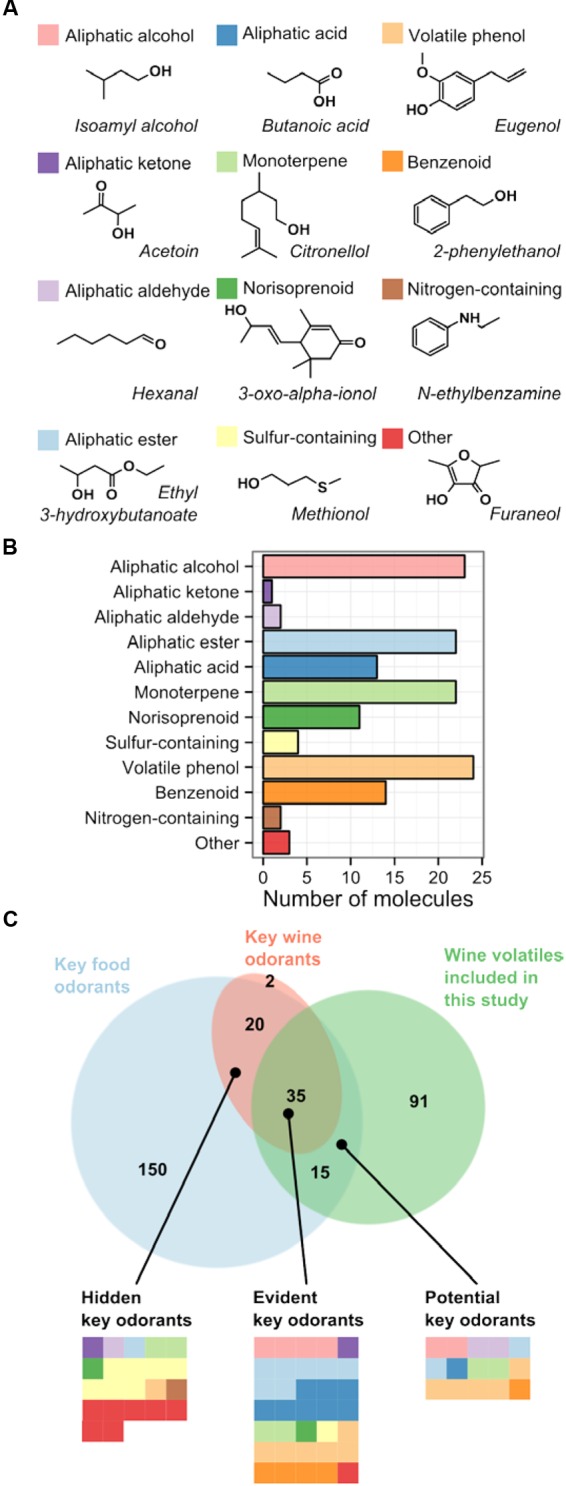
Classes of grape and wine volatile compounds evaluated in this study. (A) Classes of volatiles with examples. (B) Number of different molecules from each class that were included in this study. (C) Euler diagram of wine volatiles included in this study and key food and wine odorants, identified in two other meta-analyses. Two other meta-analyses identified volatile compounds with the strongest impact on aroma of food (Dunkel et al., 2014) and wine (Francis and Newton, 2005). While the overlap between the three studies is sizeable, many key odorants are not detected in volatile profiling experiments. Each tile represents one volatile molecule and its color corresponds to the molecular class.